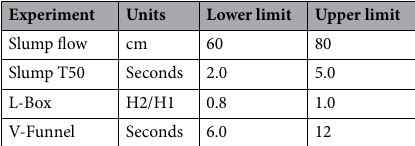
Table 6. Acceptance criteria for SCC.